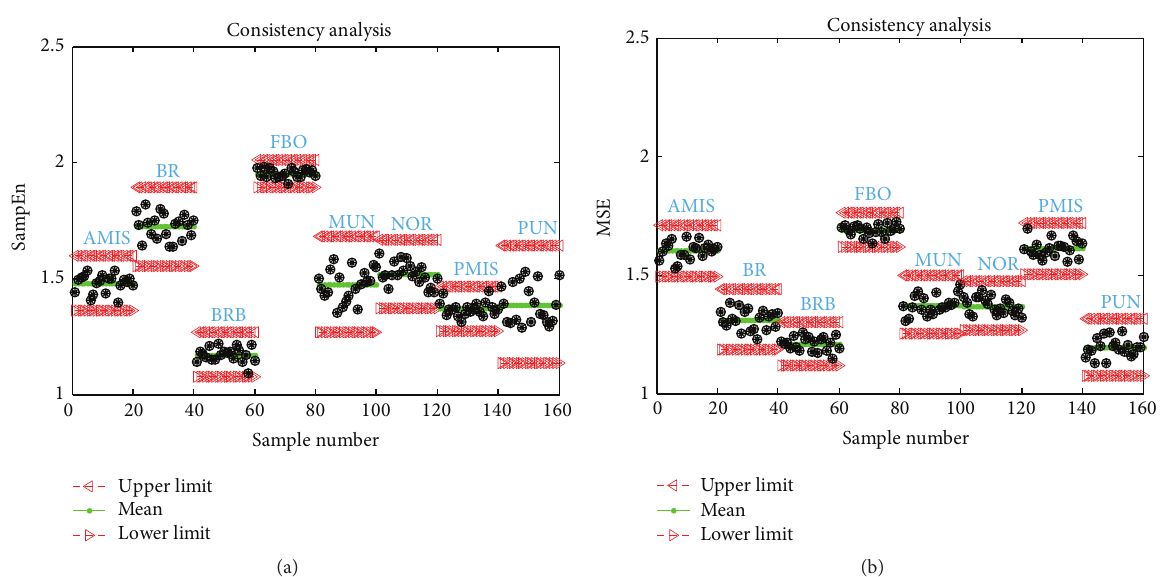
Figure 7: Consistencyanalysis of thetwo chosen entropy features. (a)Consistency analysis ofSampEn (tolerance, 𝑟 = 0.2 ) and (b) consistency analysis of MSE (scale factor, 𝜏 = 2